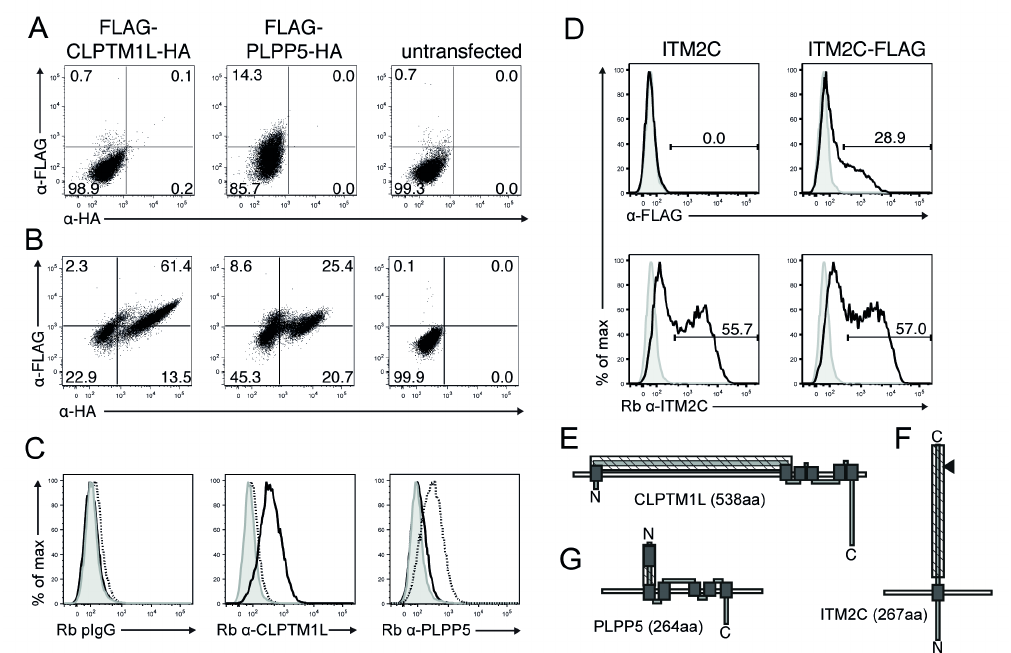
Figure 3. Cell surface expression of human PLPP5, CLPTM1L and ITM2C. FS-293F cells were transiently transfected with human CLPTM1L or PLPP5 expression constructs with N-terminal FLAG tags and C-terminal HA tags. ( A ) Cell surface or ( B ) Intra-cellular flow cytometric staining with anti-FLAG and anti-HA antibodies; ( C ) cell surface staining of transduced FS-293F cells with Rabbit (Rb) IgG control, Rb anti-CLPTM1L polyclonal (p)Ab and Rb anti-PLPP5 pAb (grey histograms: un-transfected cells, black lines: FLAG-Human-CLPTM1L-HA cells, dashed line: FLAG-Human-PLPP5-HA cells); ( D ) FS-293F cells were transiently transfected with a human ITM2C expression constructs with or without C-terminal FLAG tags. Flow cytometric analysis of surface anti-FLAG and Rb anti-ITM2C pAb staining (grey histograms: un-transfected cells, black lines: Human-ITM2C transfected cells); ( E – G ) predicted domain structure and cell surface localization of ( E ) CLPTM1L, ( F ) ITM2C and ( G ) PLPP5. (dark-grey boxes: putative TM-domains, hatched boxes: peptides used for pAb generation, black triangle Furin cleavage